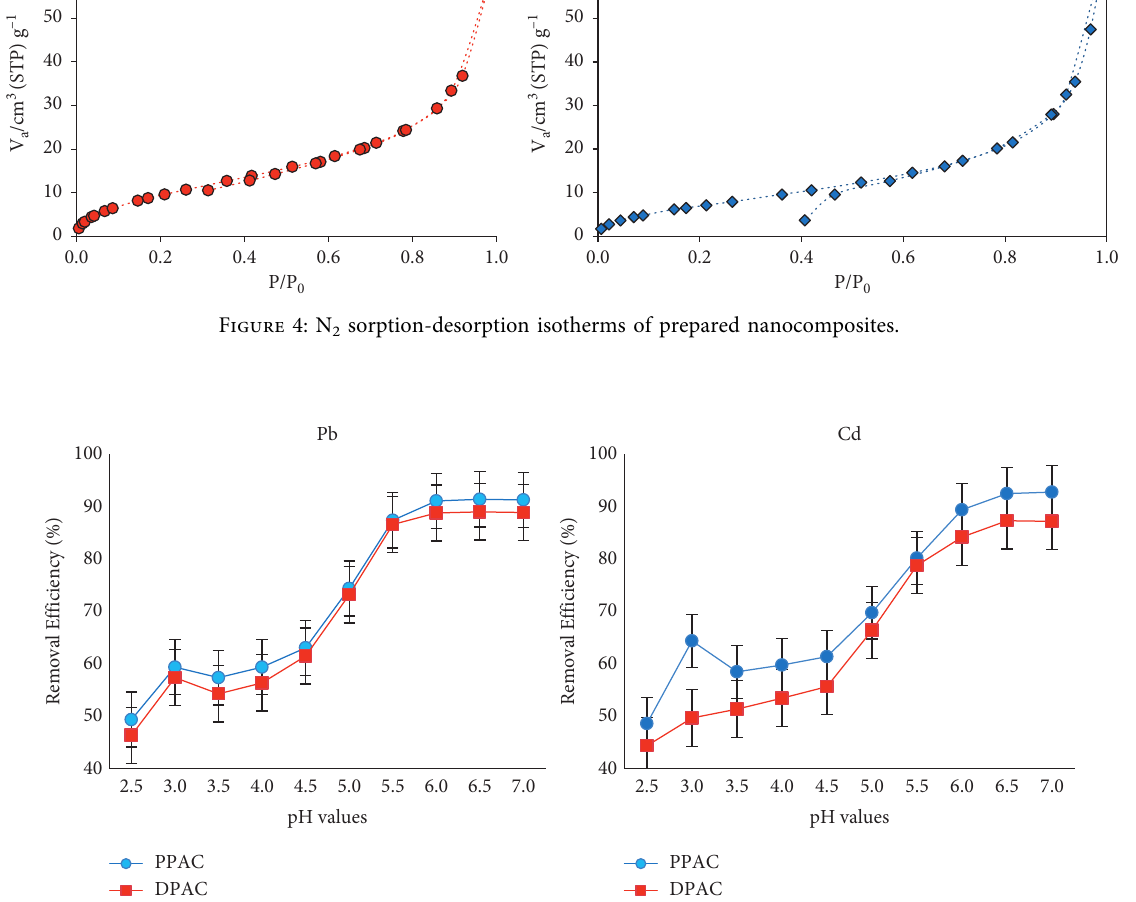
Figure 5: Effect of pH on the adsorption efficiencies of Pb(II) and Cd(II) on the surfaces of DPAC and PPAC (metal concen- tration � 100mg/L, contact time � 90min, dose of DPAC � 1g/L, and dose of PPAC �